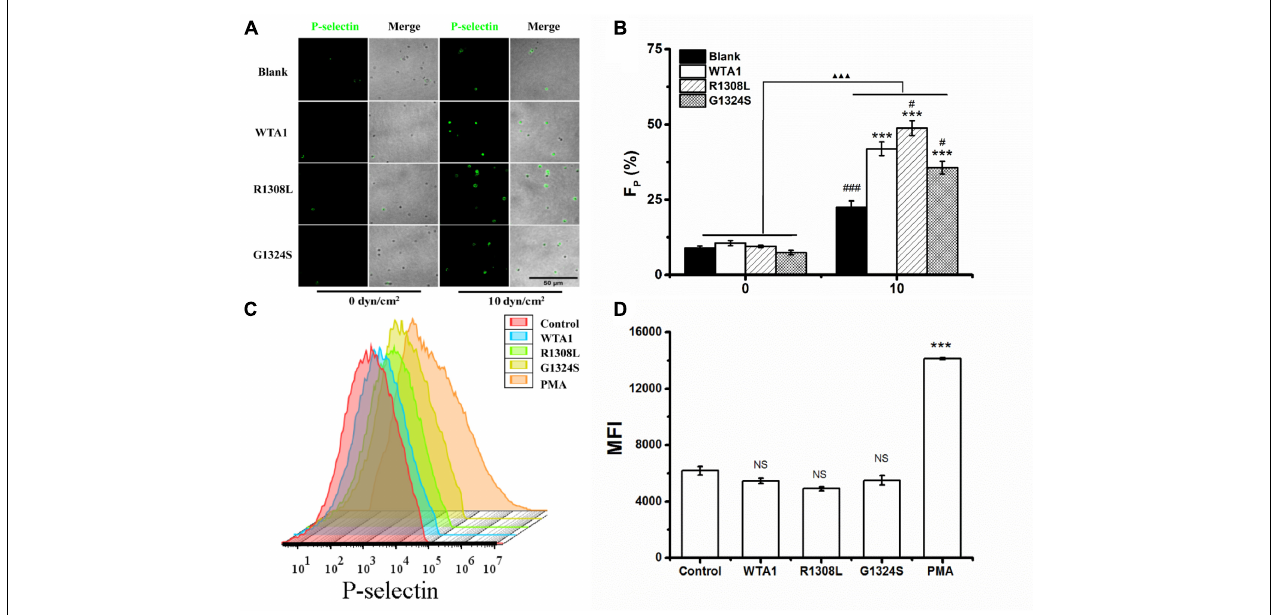
FIGURE 2 | P-selectin translocation of platelets adhered to either immobilized- and suspended-A1 domain of von Willebrand factor and its two mutants (R1308L and G1324S) with or without mechanical stimuli for 8 min. (A) P-selectin immunolocalization (green) and (B) P-selectin-positive fraction ( F P ) of platelets on substrates coated with WTA1, R1308L, and G1324S without or with fluid shear stress stimulus of 10 dyn/cm 2 for a stimulus time of 8 min. Merged images of differential interference contrast and green fluorescence are shown with bar = 50 µ m. The data represent the mean ± SEM from three independent experiments. Statistical significance was analyzed by two-way ANOVA for multiple comparisons with Bonferroni post hoc test; *** p < 0.001 compared with the blank group, # p < 0.05 and ### p < 0.001 compared with WTA1 group, and (cid:49)(cid:49)(cid:49) p < 0.001 compared with 0 dyn/cm 2 group. (C) Representative flow cytometry histograms of P-selectin translocation for platelets treated without (control) or with WTA1, R1308L, G1423S, and PMA. (D) Bar graph representing the mean fluorescence intensity of P-selectin-positive platelets (MFI) in various treatments from flow cytometry. All data are shown as mean ± SEM from three independent experiments and analyzed by one-way ANOVA for multiple comparisons. *** p < 0.001; NS, not significant compared with the control